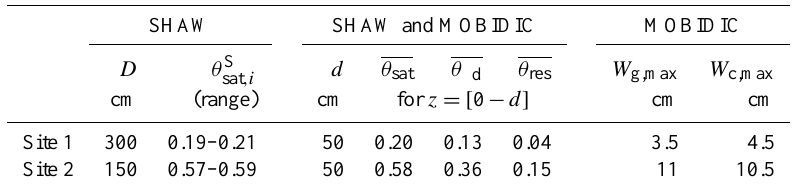
Table 3. Summary of modeled soil depths and calibrated soil water capacities. D is the total soil depth modeled in SHAW while d is the soil depth modeled in MOBIDIC and the depth used for